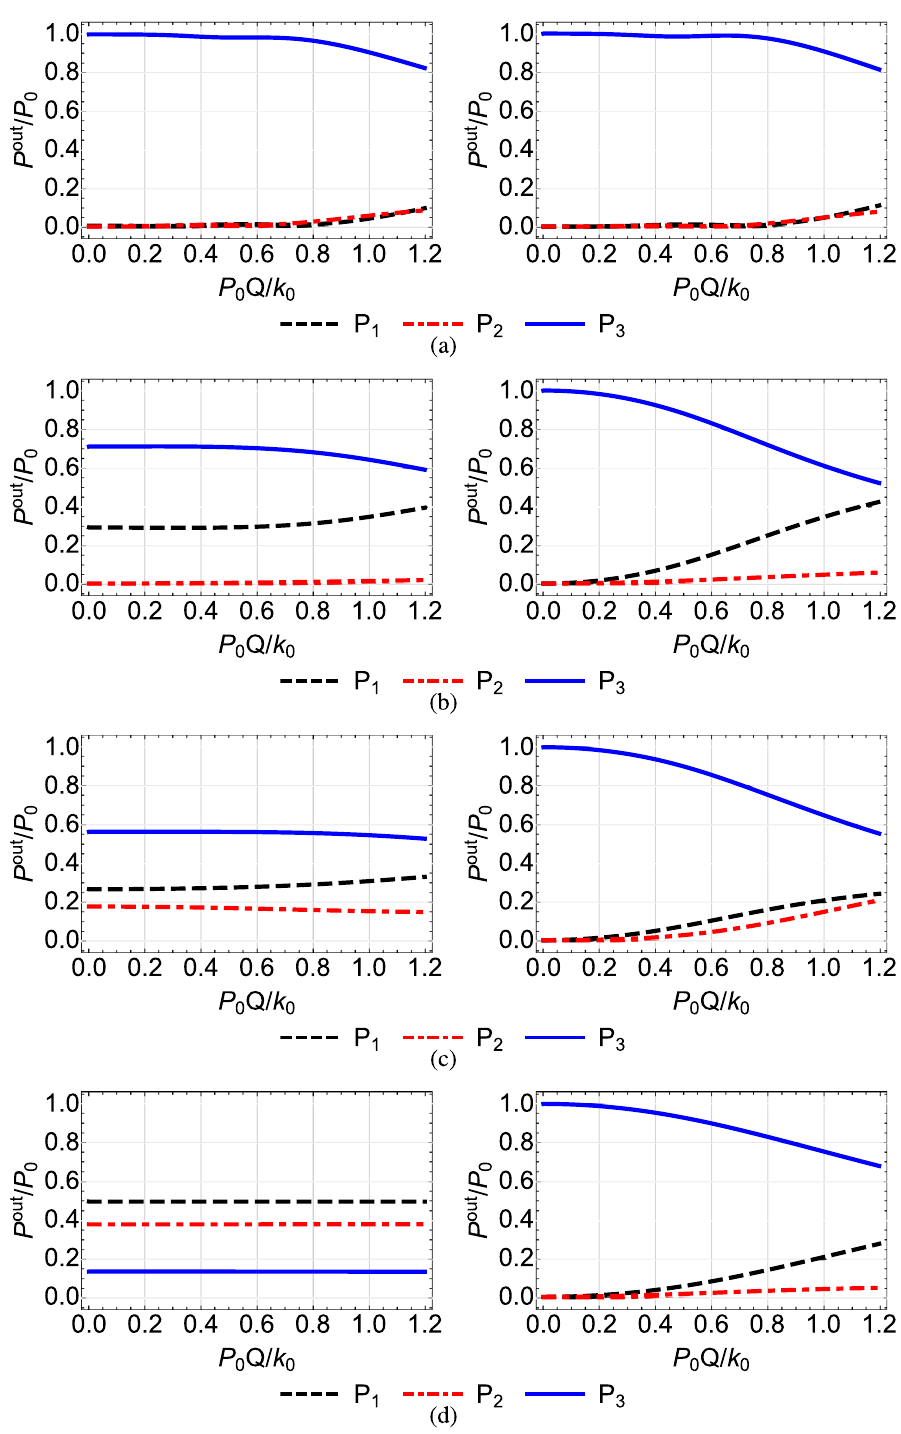
out P P i ( Z )/ P 0 0 at each waveguide as a function of the normalized i / = Q , for the Gaussian (left column) and modified shortcut (right 0, Q 2 0, Q 3 = = =